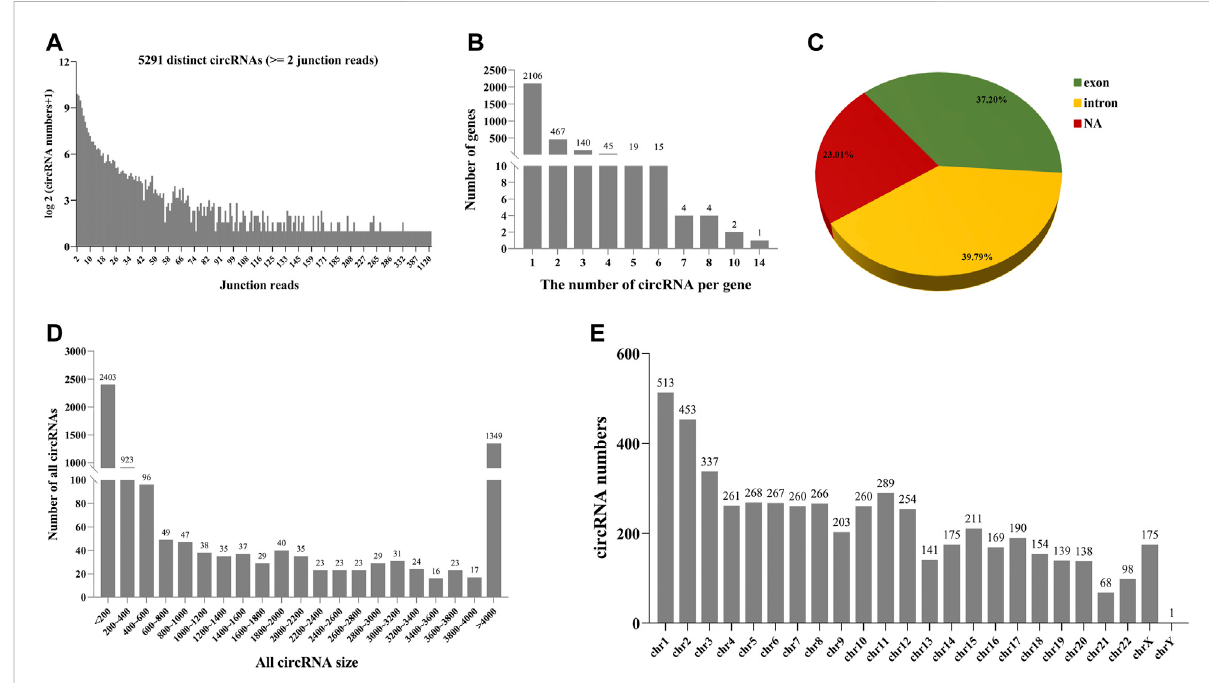
FIGURE 4 Number and characteristics of identi fi ed circRNAs in follicular fl uid. (A) Number of identi fi ed circRNAs and junction reads in follicular fl uid. (B) Number distribution of formed circRNAs per gene in follicular fl uid. (C) Source of circRNAs identi fi ed in follicular fl uid. NA: not assigned. (D) Distribution of circRNA length in follicular fl uid. (E) Distribution of circRNAs in different